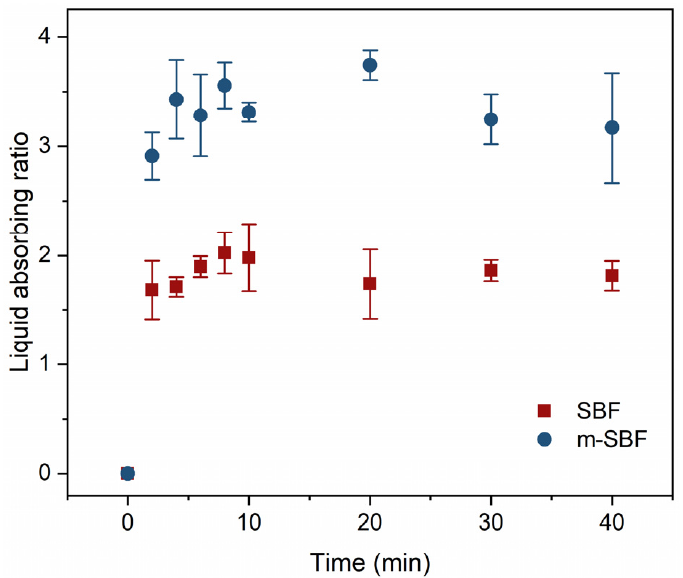
Figure 4. Liquid absorbing ratio of CA in SBF and m-SBF. The Kruskal–Wallis test was performed with a p -value of <0.05 being considered significant.